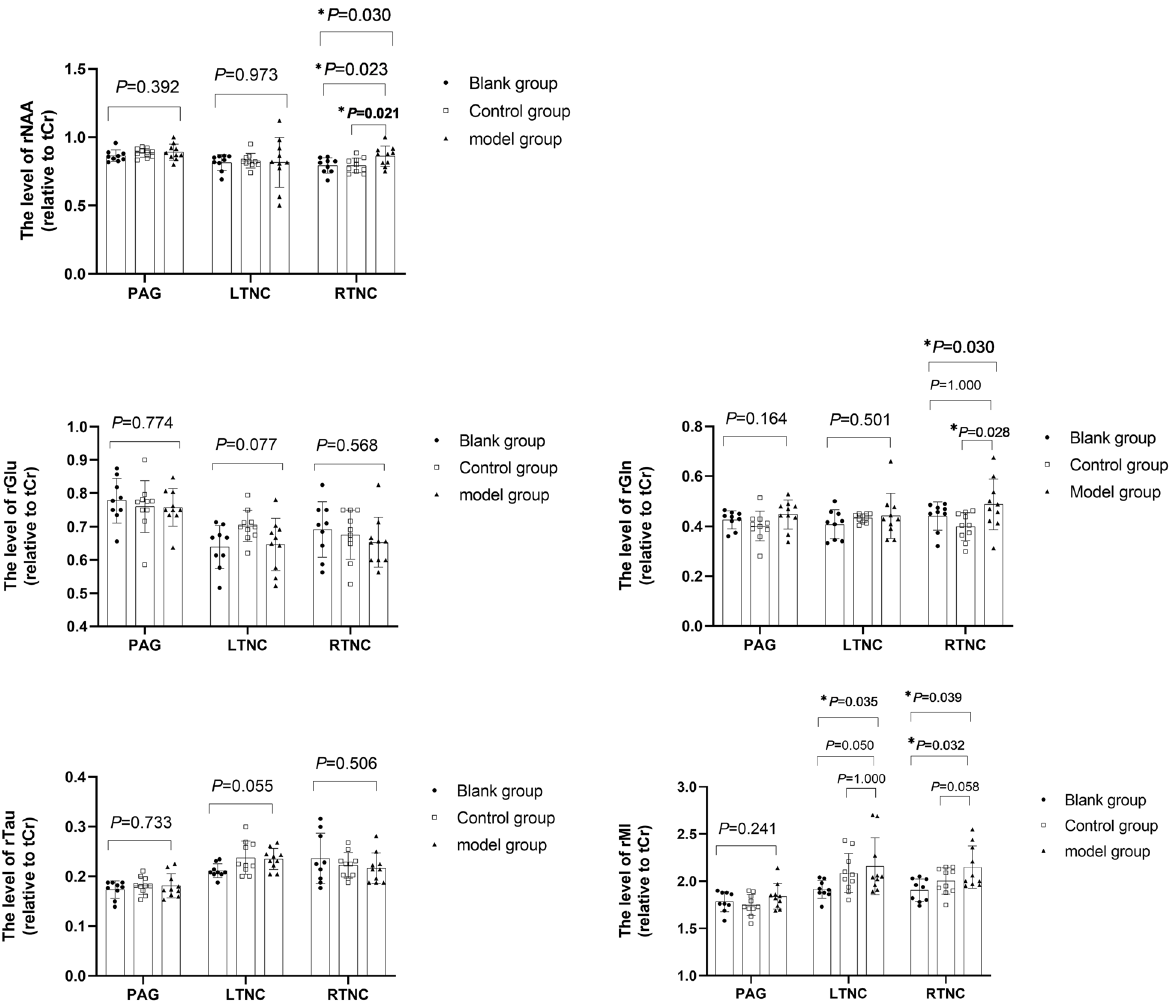
Fig. 2 Comparison of rNAA, rGln, rGlu, rTau and rMl in PAG, LTNC and RTNC ( n in the control group were lower than the model group, while the rGlu, rTau of RTNC had no significant difference between